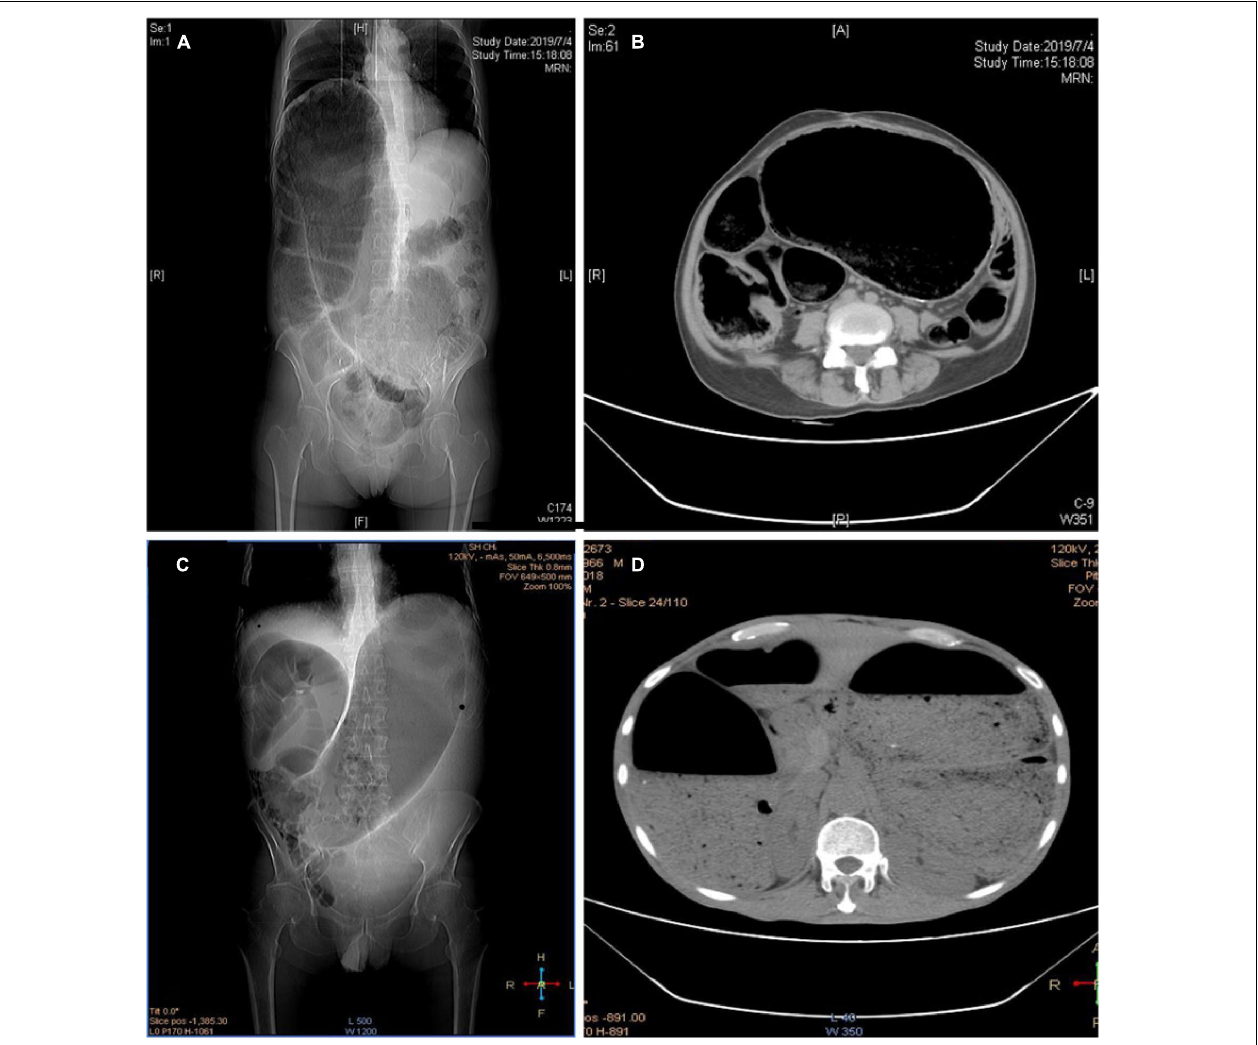
FIGURE 4 | (A,B) CT image of iatrogenic megacolon caused by colonic anastomotic stenosis; (C,D) CT images of iatrogenic megacolon after radiotherapy for rectal